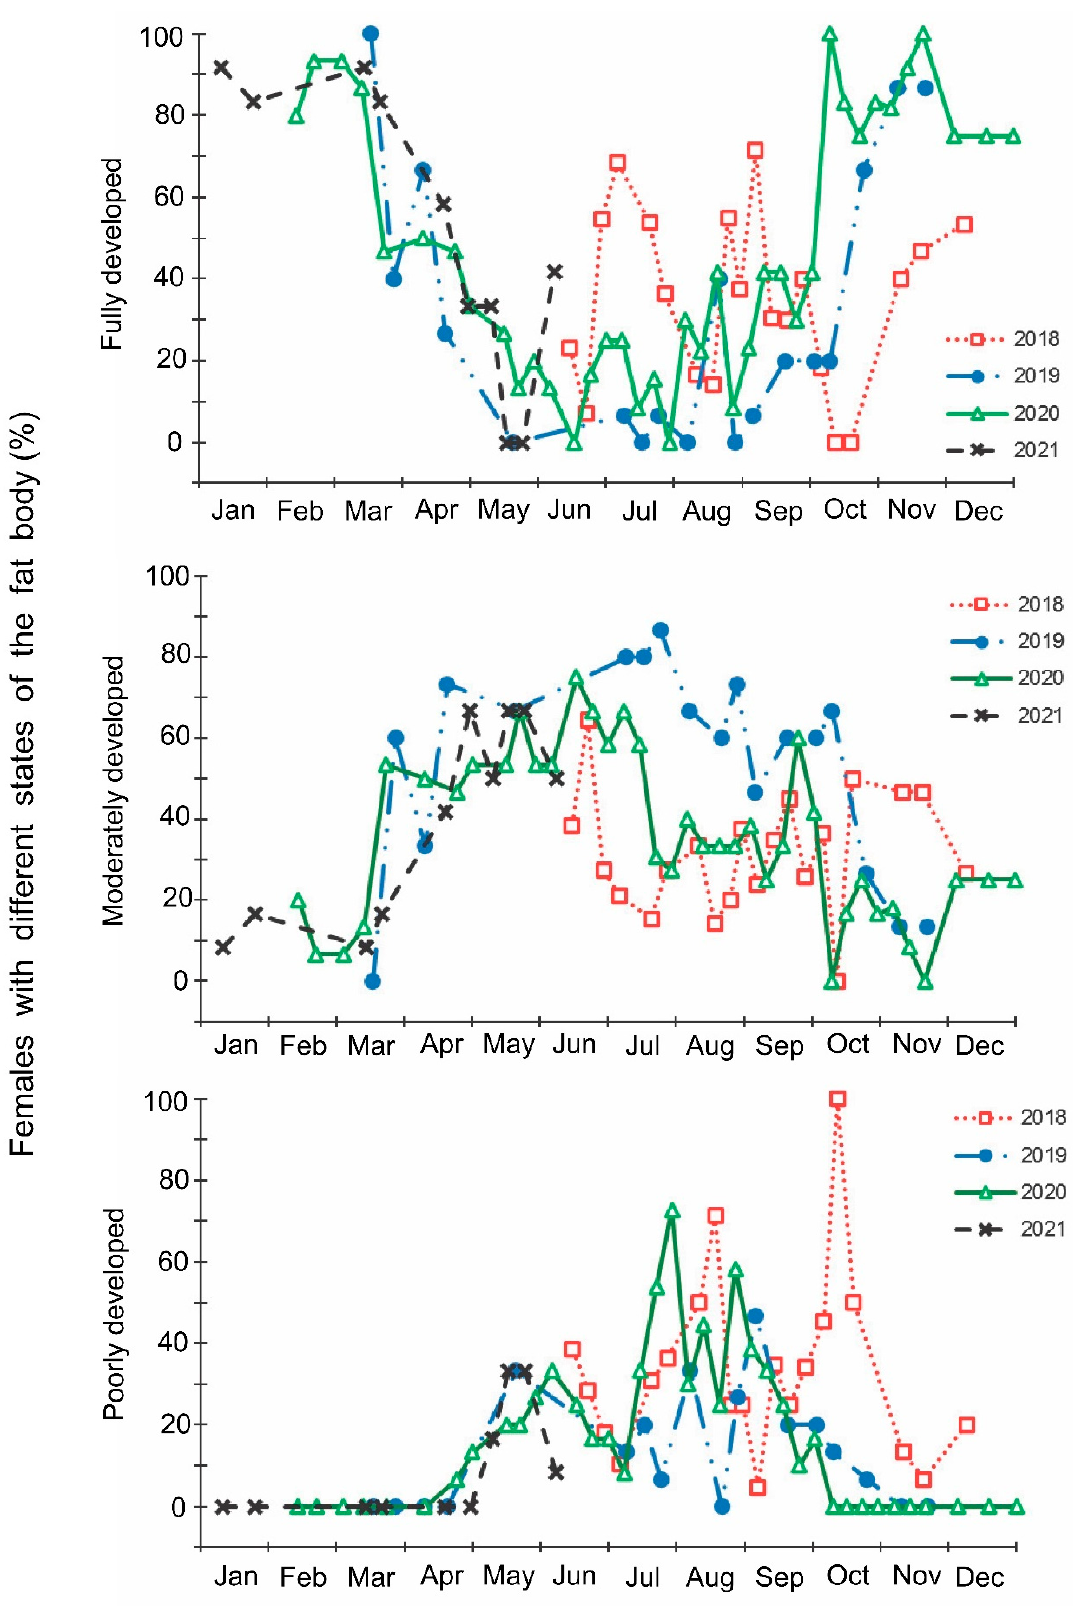
Figure 6. Seasonal changes in the proportions of Halyomorpha halys females with different states of fat body during 2018–2021. Each symbol corresponds to one sample of field-collected females (6–35 females per sample with a total of 1180 females in 85 samples).